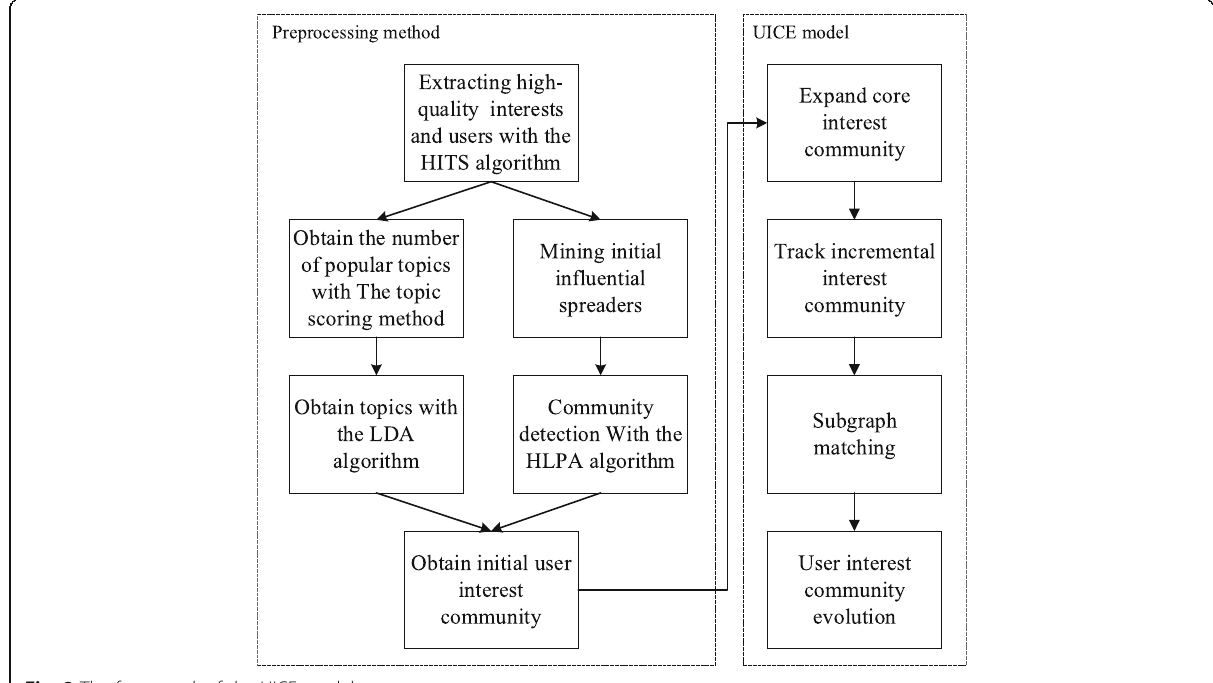
Fig. 2 The framework of the UICE